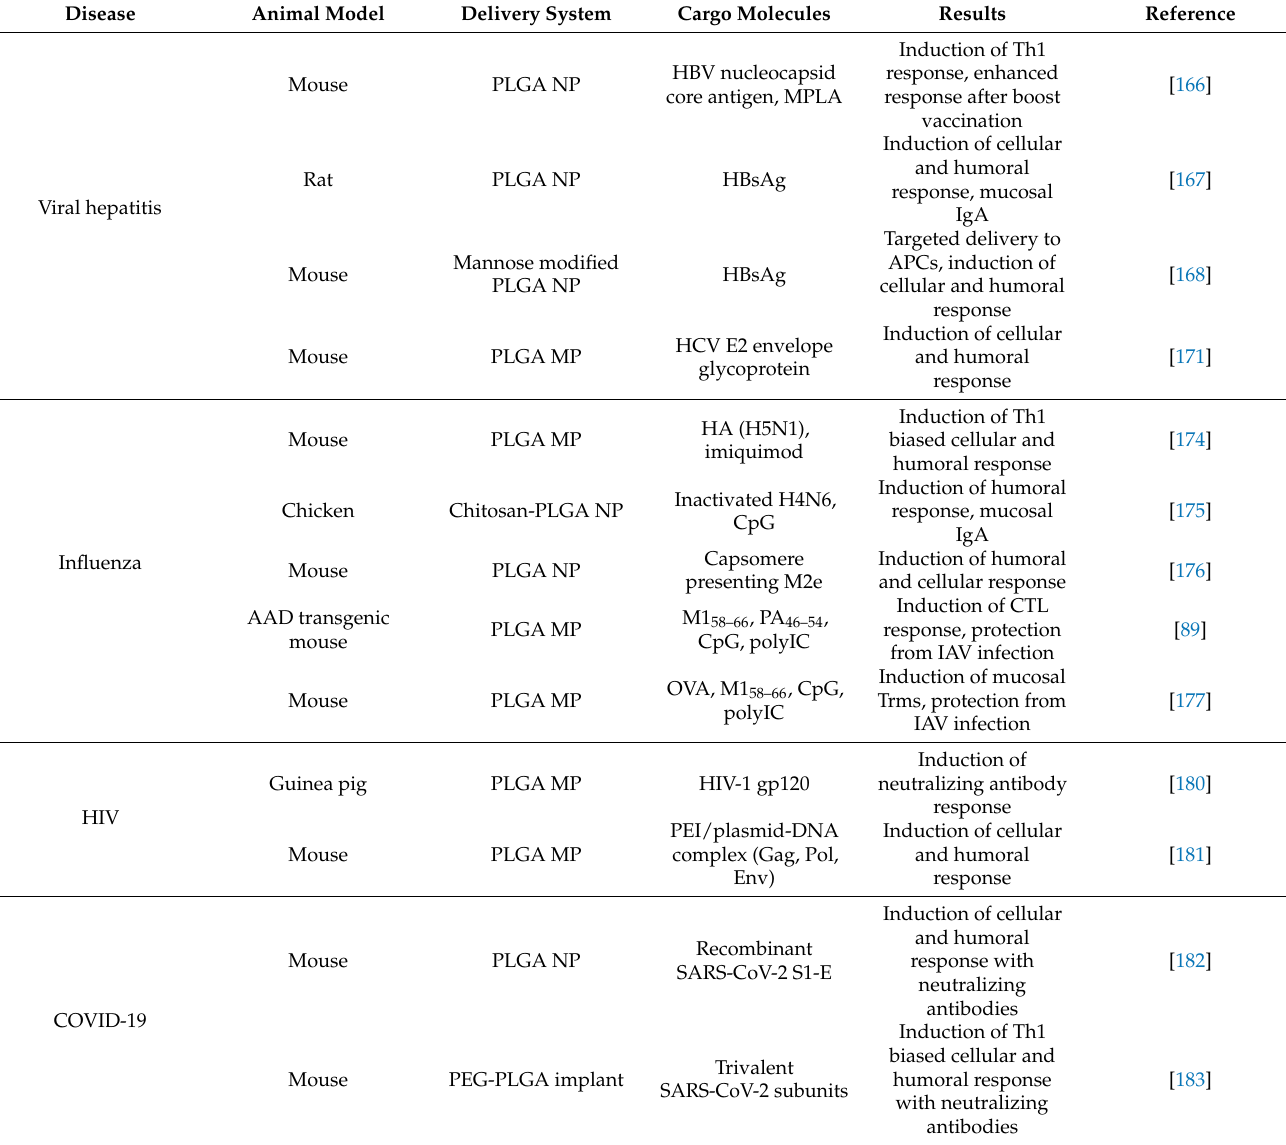
Table 4. Summary of PLGA-mediated immunotherapy of infectious